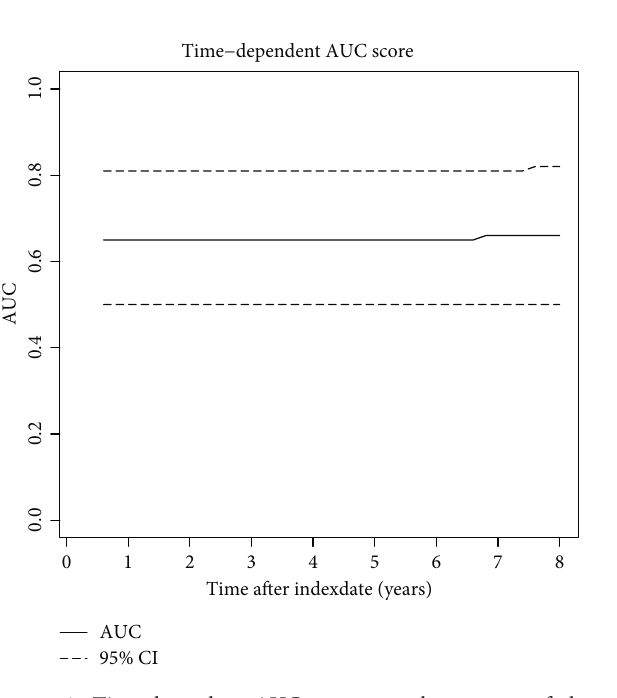
Figure 2: Time-dependent AUC scores on the test set of the regularized Cox model until 8 years after the index